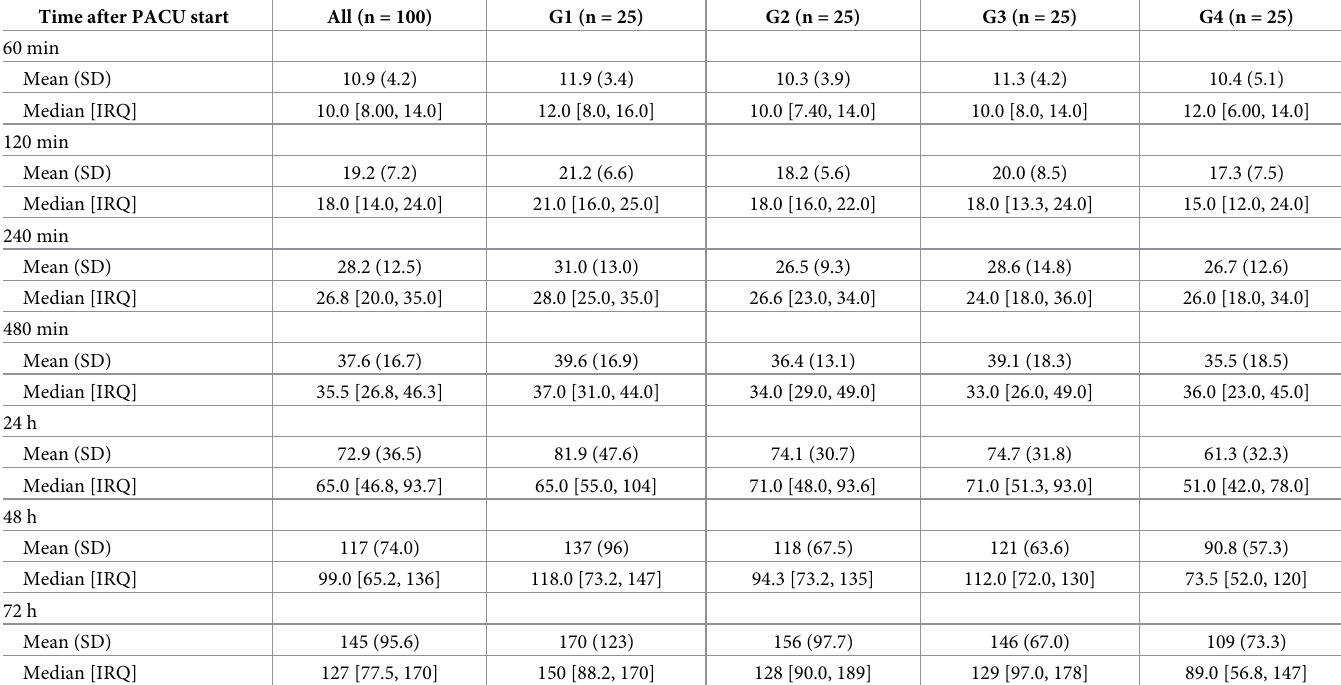
Table 2. Oxycodone consumption during the study after the beginning of PACU care.